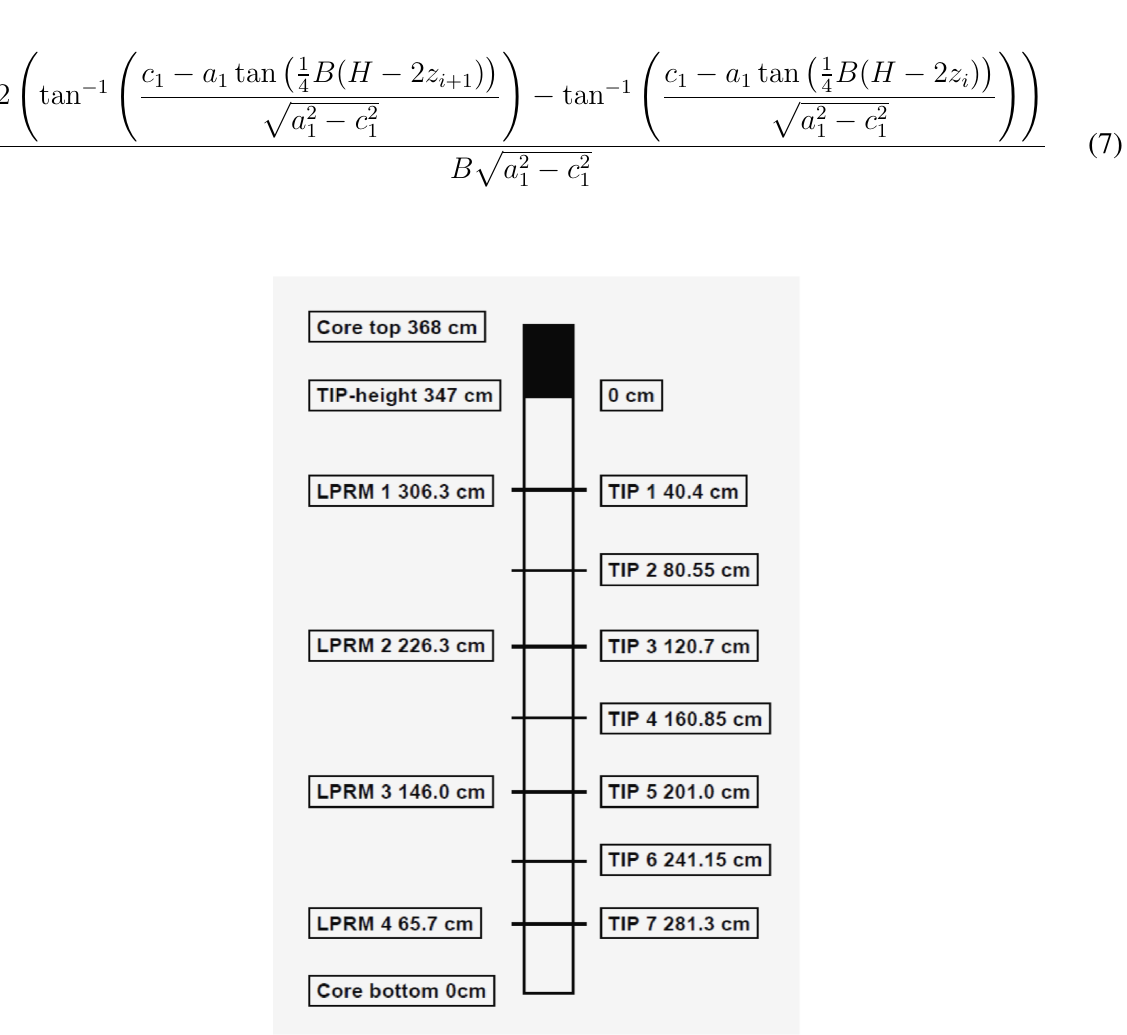
Figure 3: Layout of the measurements